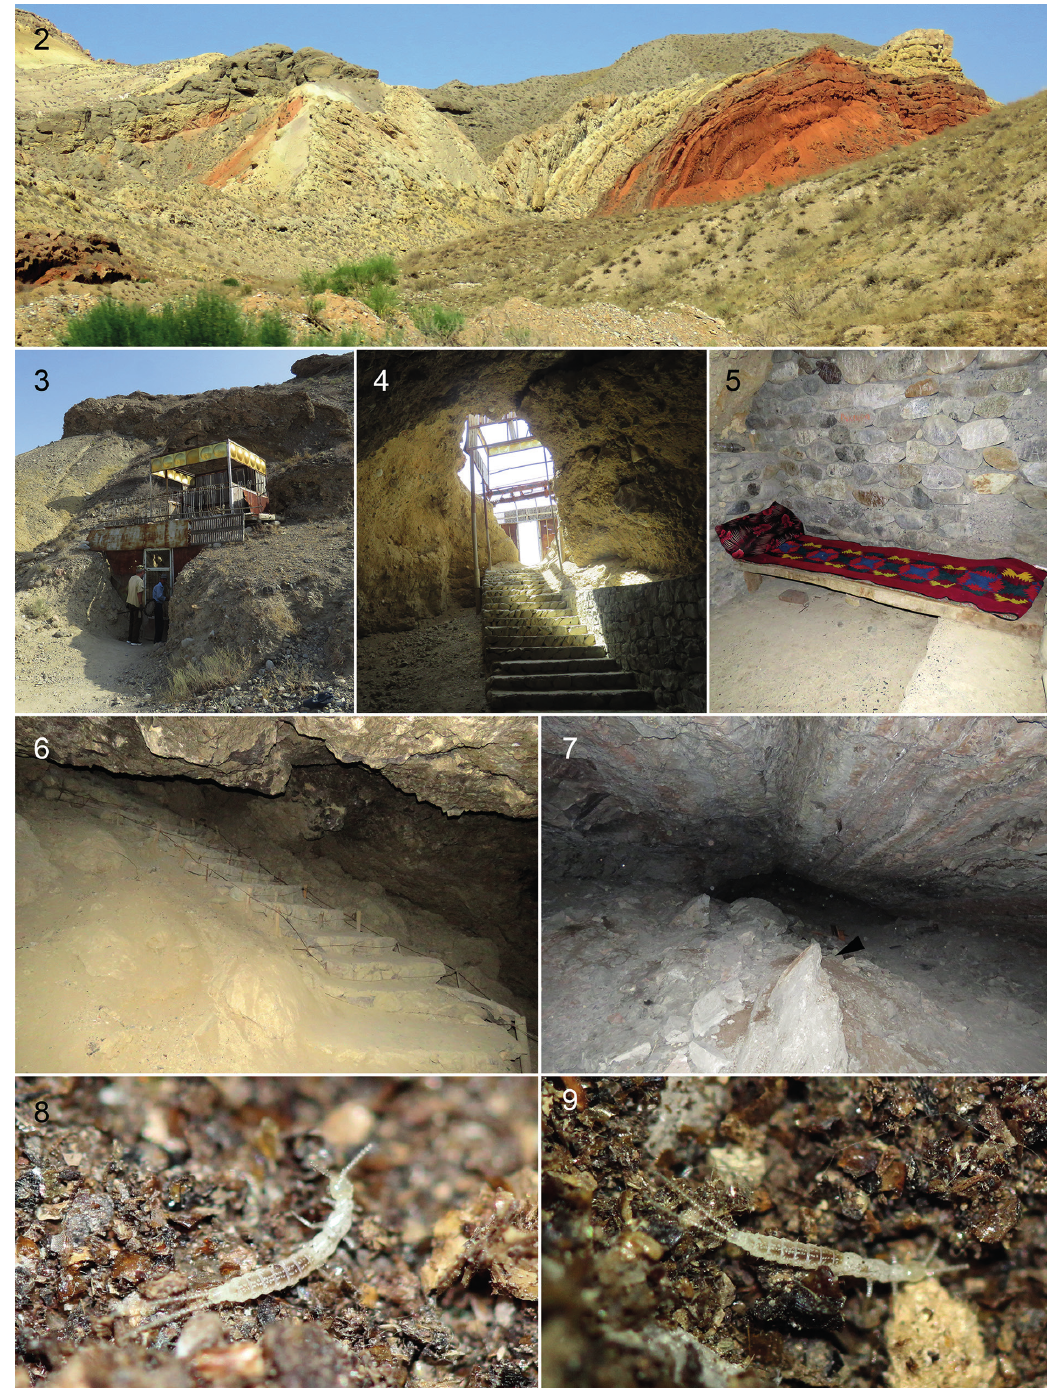
Figs 2−9. Ak-Turpak Cave, Kadamjay District, Batken Region in Kyrgyzstan in Central Asia. 2 . Whitish, pinkish, or reddish clayey ground surface where the entrance is located. 3 . Entrance of the cave, exterior view. 4 . Entrance of the cave, interior view. 5 . Small platforms and mattresses near the entrance. 6 . Stairs installed deep inside the cave. 7 . Last chamber of the cave, which is always associated with old bat guano. 8 . Individual of Kyrgyzstancampa sanare Sendra & Ferreira gen. et sp. nov., observed amidst guano. 9 . Another specimen of K. sanare Sendra & Ferreira gen. et sp.